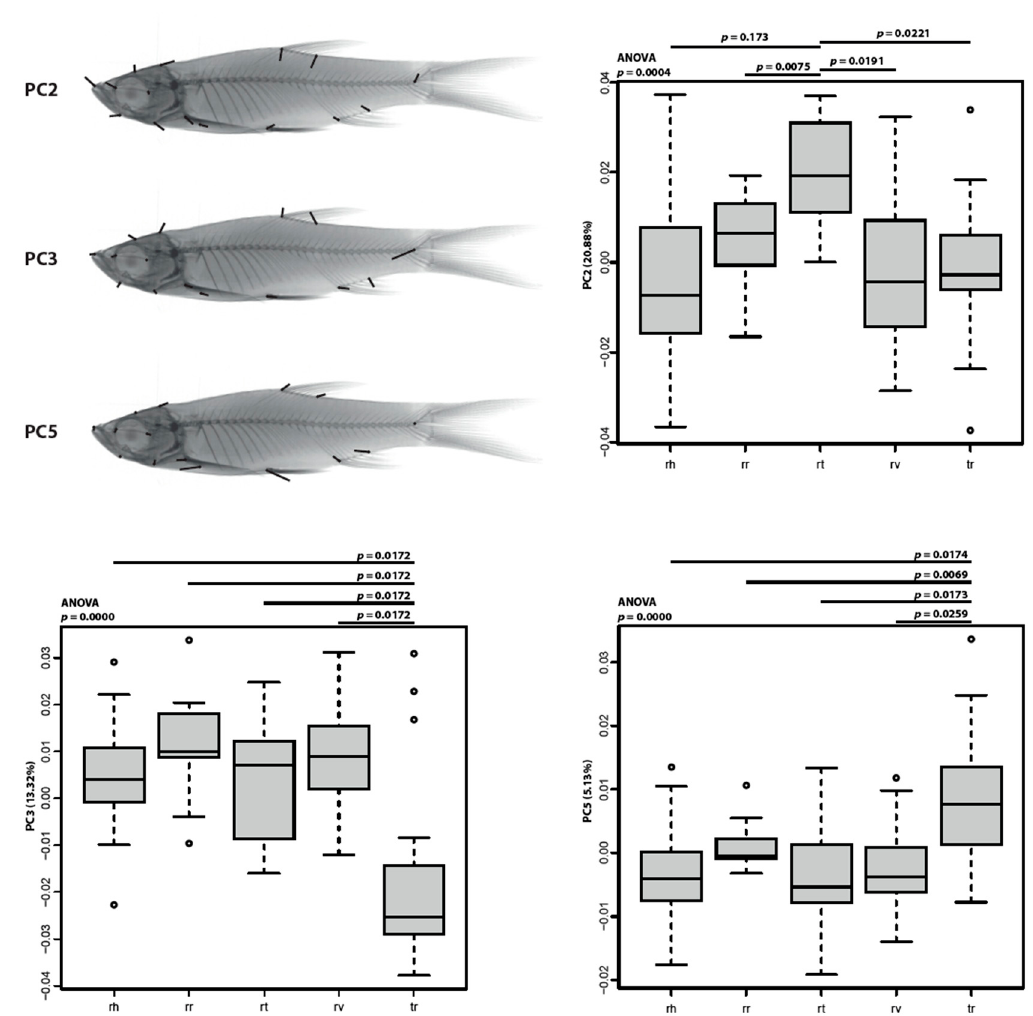
Figure 3. Shape changes resulting from a PCA for the relevant PCs are displayed in the upper left corner. The boxplots of PCs with significant shape differences according to a one-way ANOVA show interspecific differences. Results of the one-way ANOVA for each PC are displayed in the upper left corner of each plot and p -values resulting from Tukey ´ s pairwise post-hoc test are displayed over the black solid horizontal lines connecting relevant